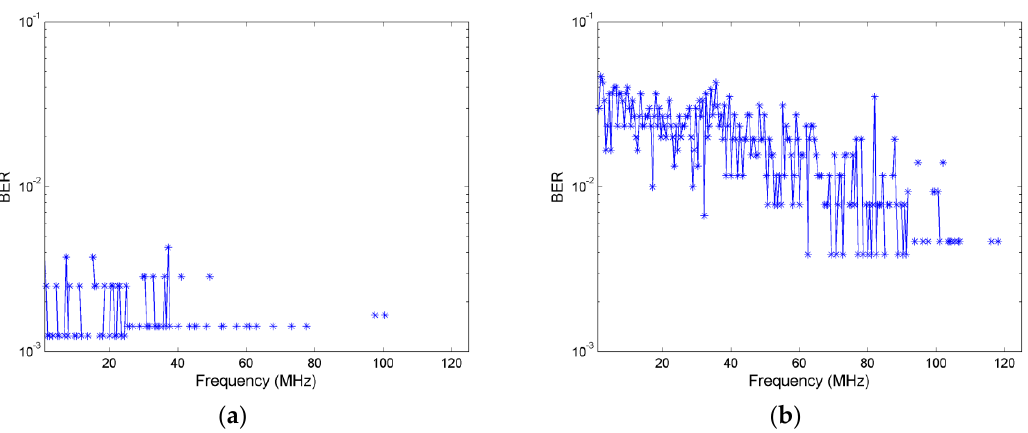
Figure 8. Received bit error rate (BER) in each sub ‐ carrier ( a ) bias 20 mA, 6 dBm; ( b ) bias 22mA, 8dBm.